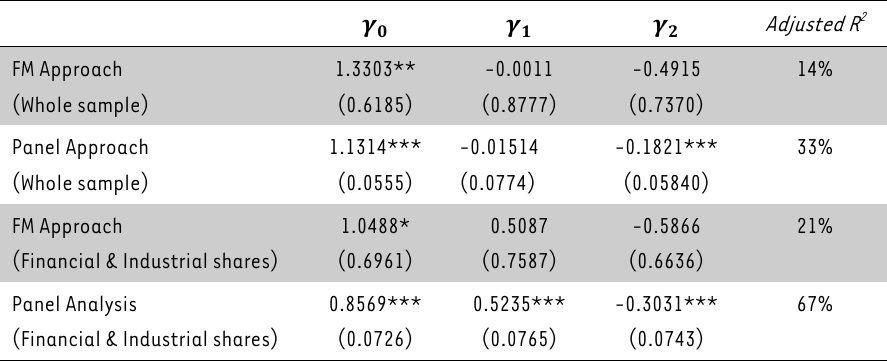
TABLE 4: Coefficient Estimates for the Dual-Beta CAPM